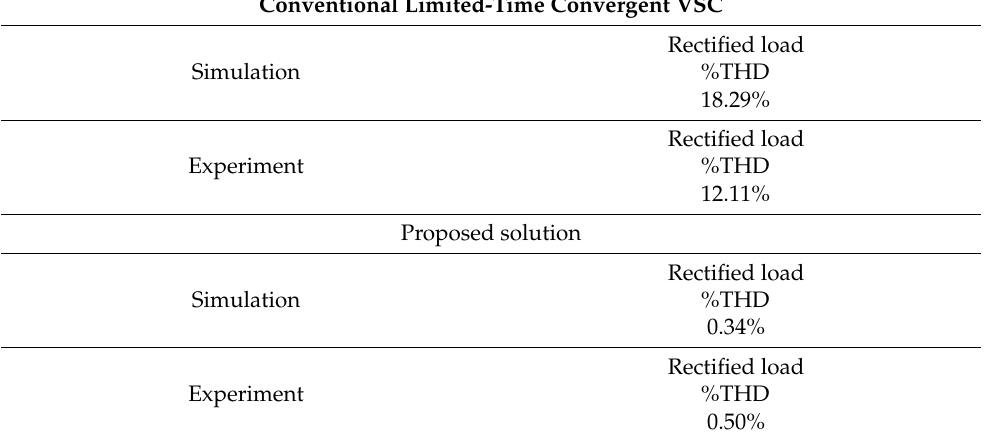
Table 2. %THD of output voltage.